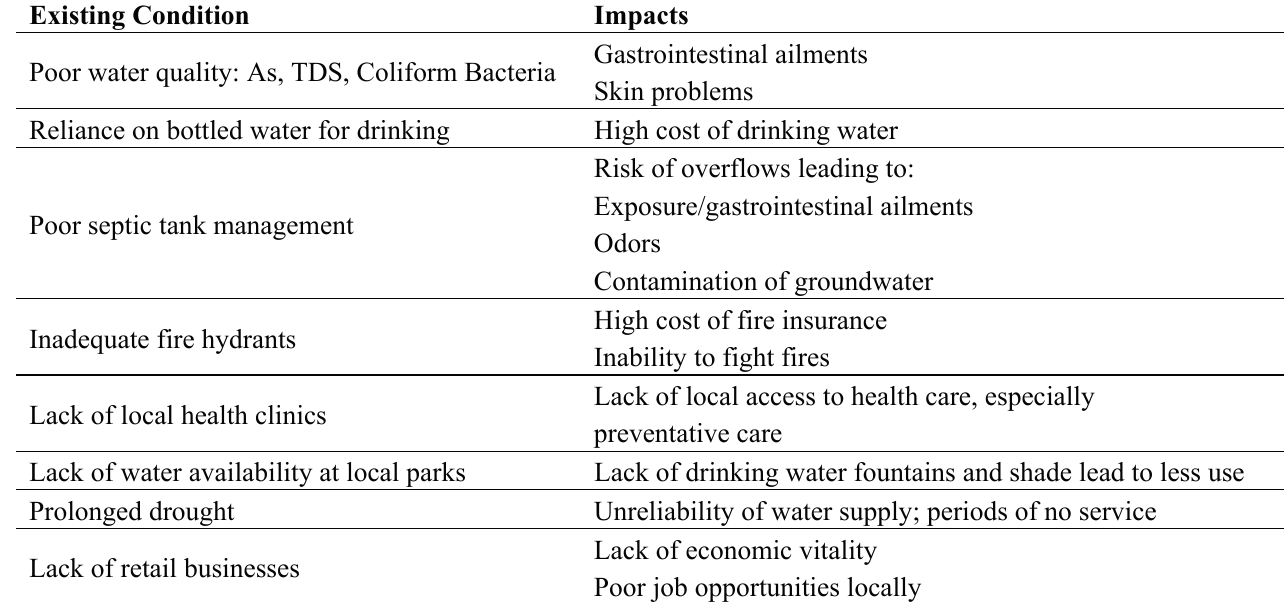
Table 5. Summary of existing conditions and their impacts identified through the